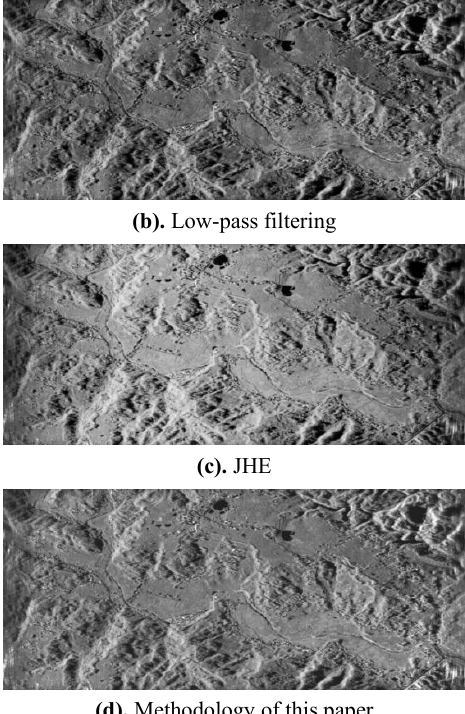
Figure 3. HV-polarized SAR images of the Ya'an